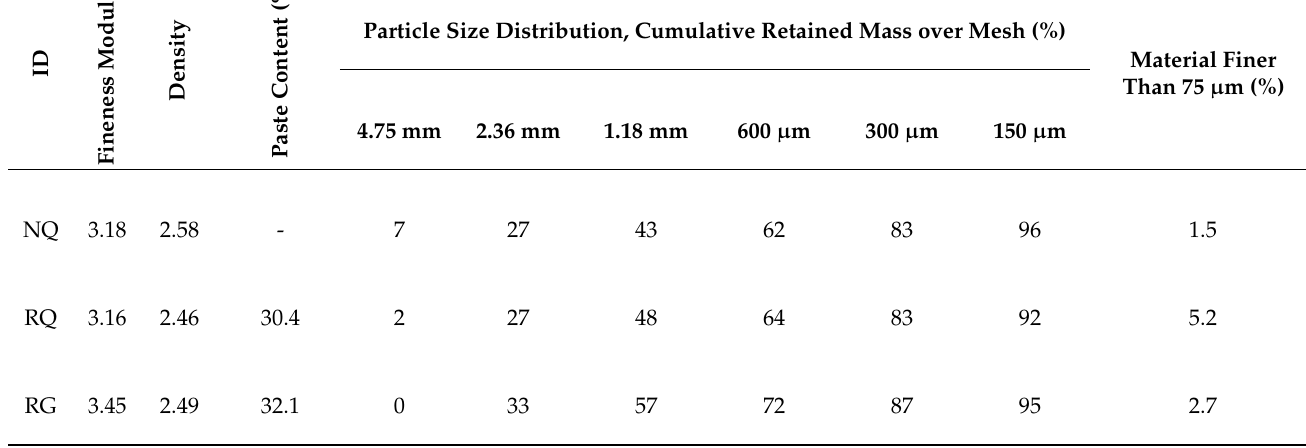
Table 1. Aggregates properties.